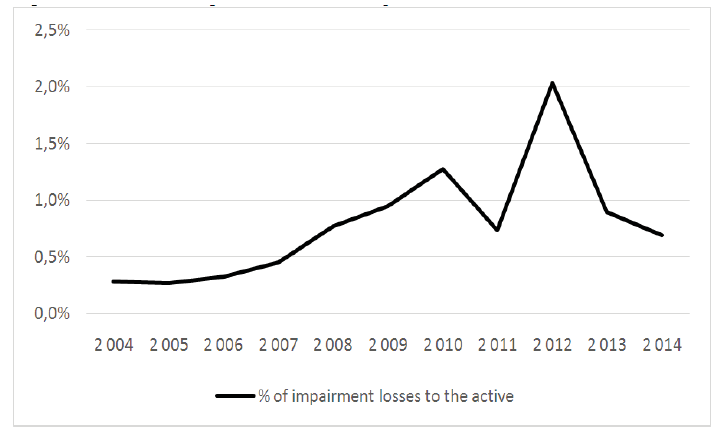
Fig. 1. Evolution of impairment losses in the period 2004 to